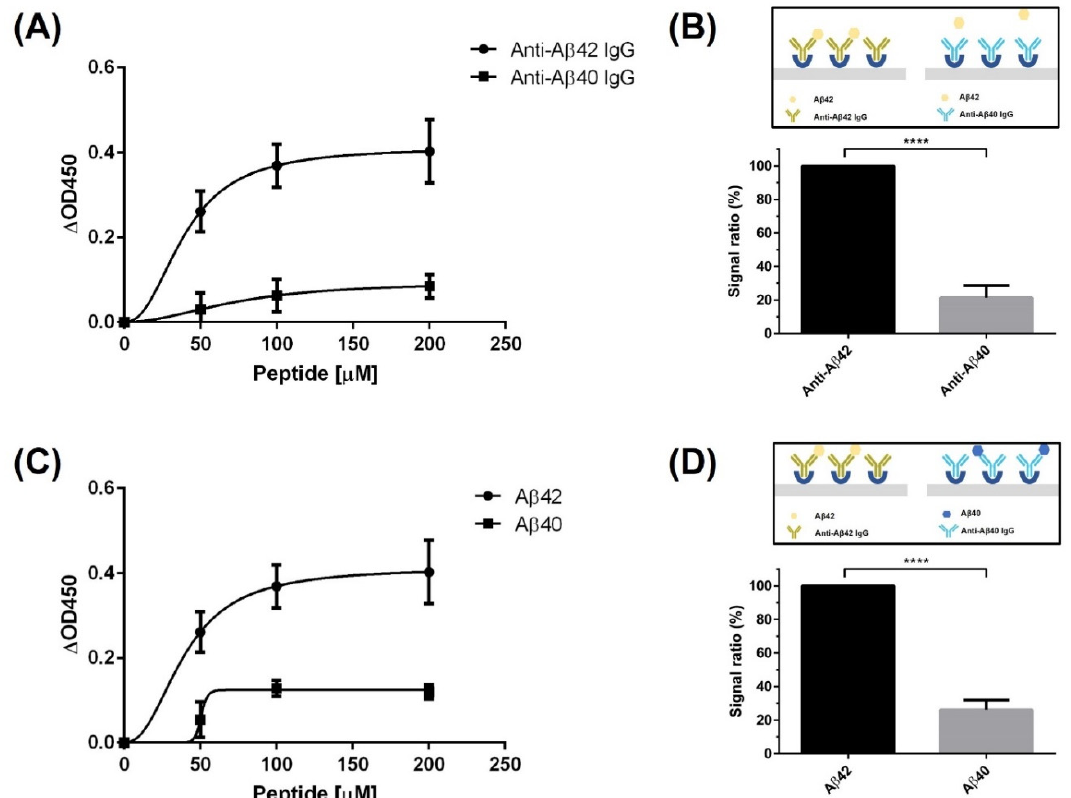
Figure 3. Verification of the A β -specific binding in the peptide-based diagnostic method. ( A ) Comparison of signals using two kinds of A β -specific antibodies. The signal was shown only when using the anti-A β 42 antibody when A β 42 was added to the antibody-coated plate. ( B ) The ratio of signals resulting from using the anti-A β 42 antibody and the anti-A β 40 antibody with A β 42. An unpaired t -test was performed for statistical analysis (**** p ≤ 0.0001). ( C ) Comparison of signals when A β 42 and A β 40 were added to plates coated with antibodies specific to each respective A β species. ( D ) The ratio of signals resulting from A β 42 detection by anti-A β 42 antibody to those resulting from A β 40 detection by anti-A β 40 antibody on antibody-coated plates specific to each of the A β species. An unpaired t -test was performed for statistical analysis (**** p ≤ 0.0001). All tests were performed in triplicate under the same conditions.